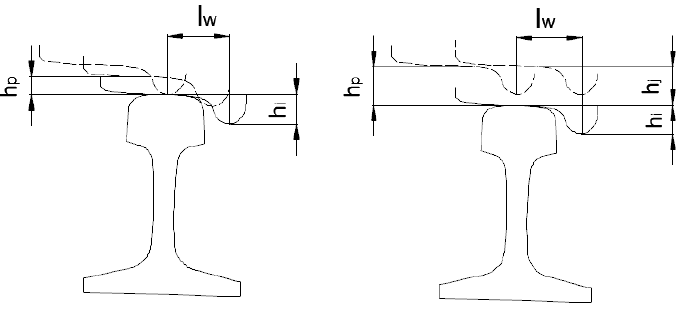
Figure 4. Geometric state of wheel – rail during derailment.